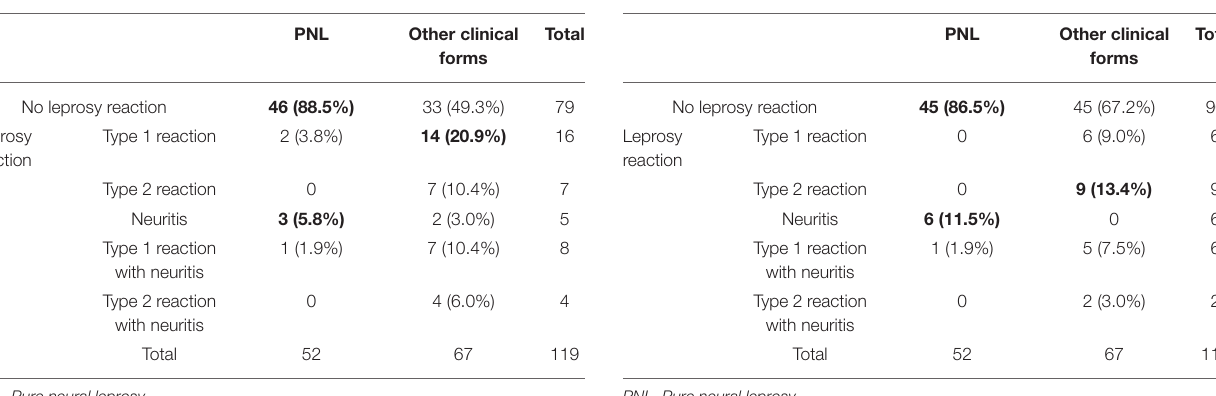
PNL, Pure neural leprosy.